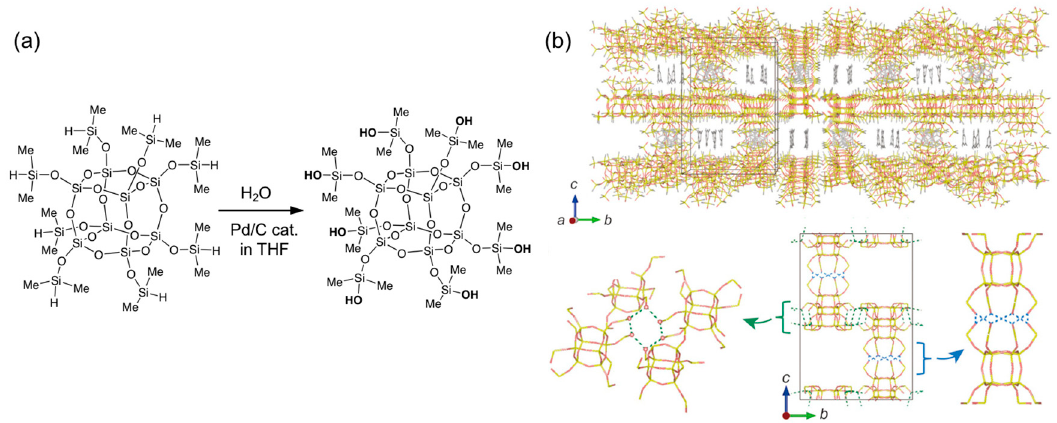
Figure 5. ( a ) Synthesis of dimethylsilanol-modified cage siloxane. ( b ) Structure of the molecular crystal of dimethylsilanol-modified cage siloxanes. Reproduced with permission from [55]. Copyright 2018, WILEY-VCH Verlag GmbH & Co. KGaA, Weinheim.